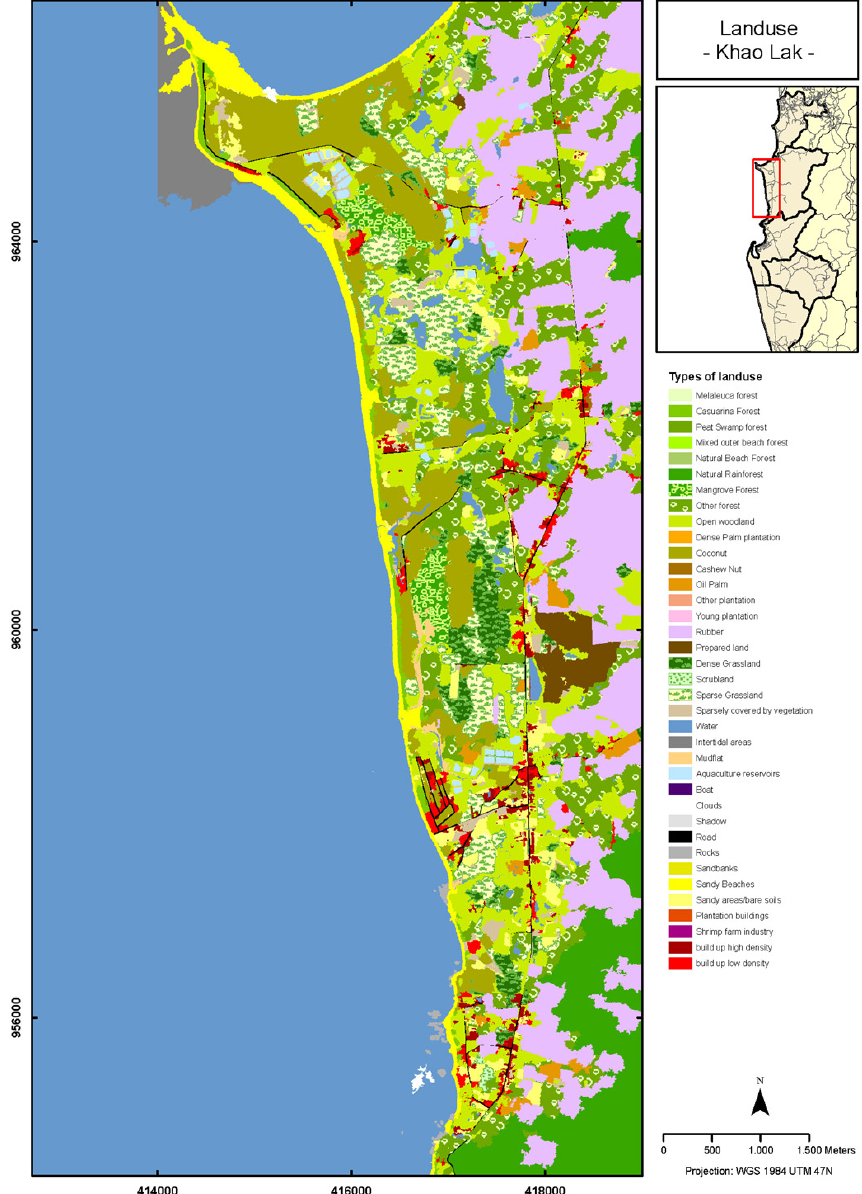
Fig. 3. LULC map exemplified for Khao Lak, based on IKONOS imagery from 13 January 2003.